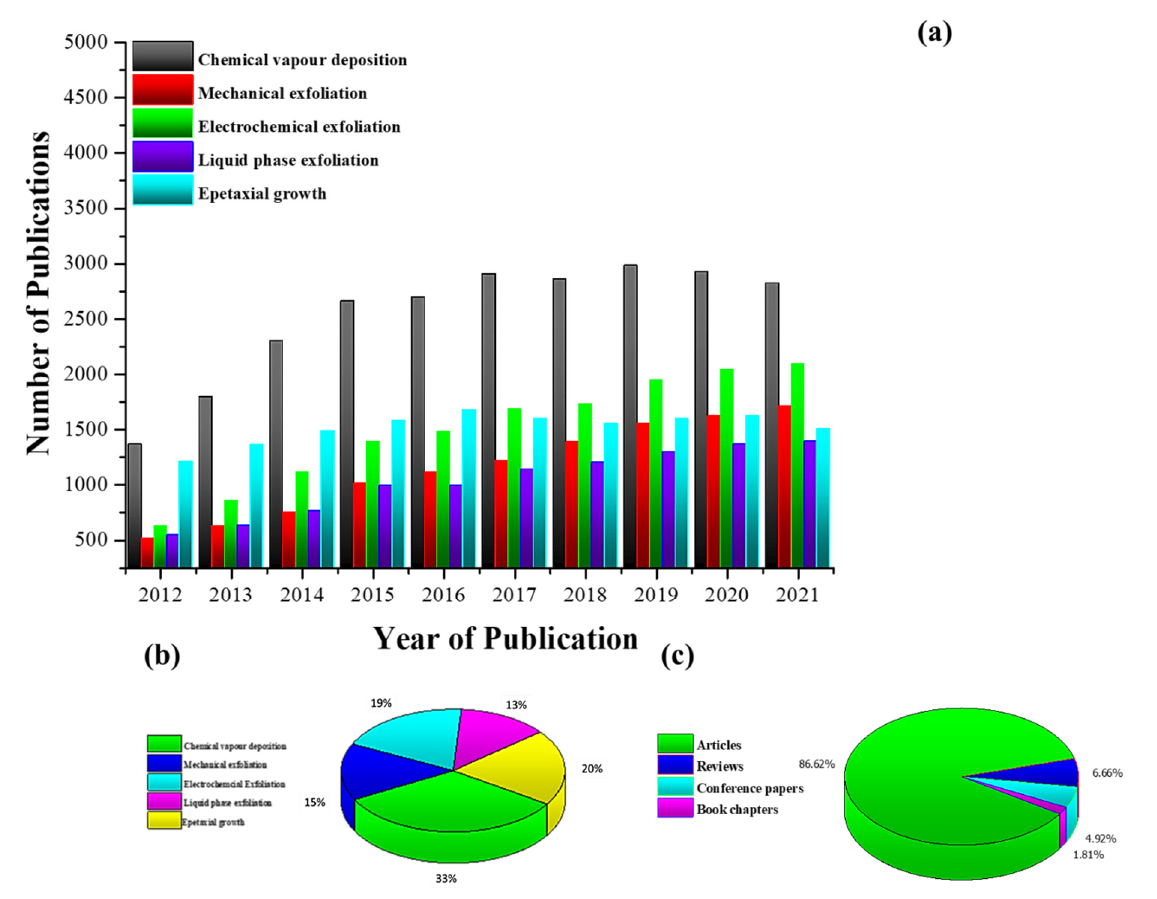
Figure 16. ( a ) Publication trend of graphene synthesis techniques from 2010 to 2021, ( b ) Percentage publications for each graphene synthesis techniques, ( c ) Type of publications of the graphene synthesis techniques. All self-extracted from Scopus (www.scopus.com) (accessed on 11 September 2022).